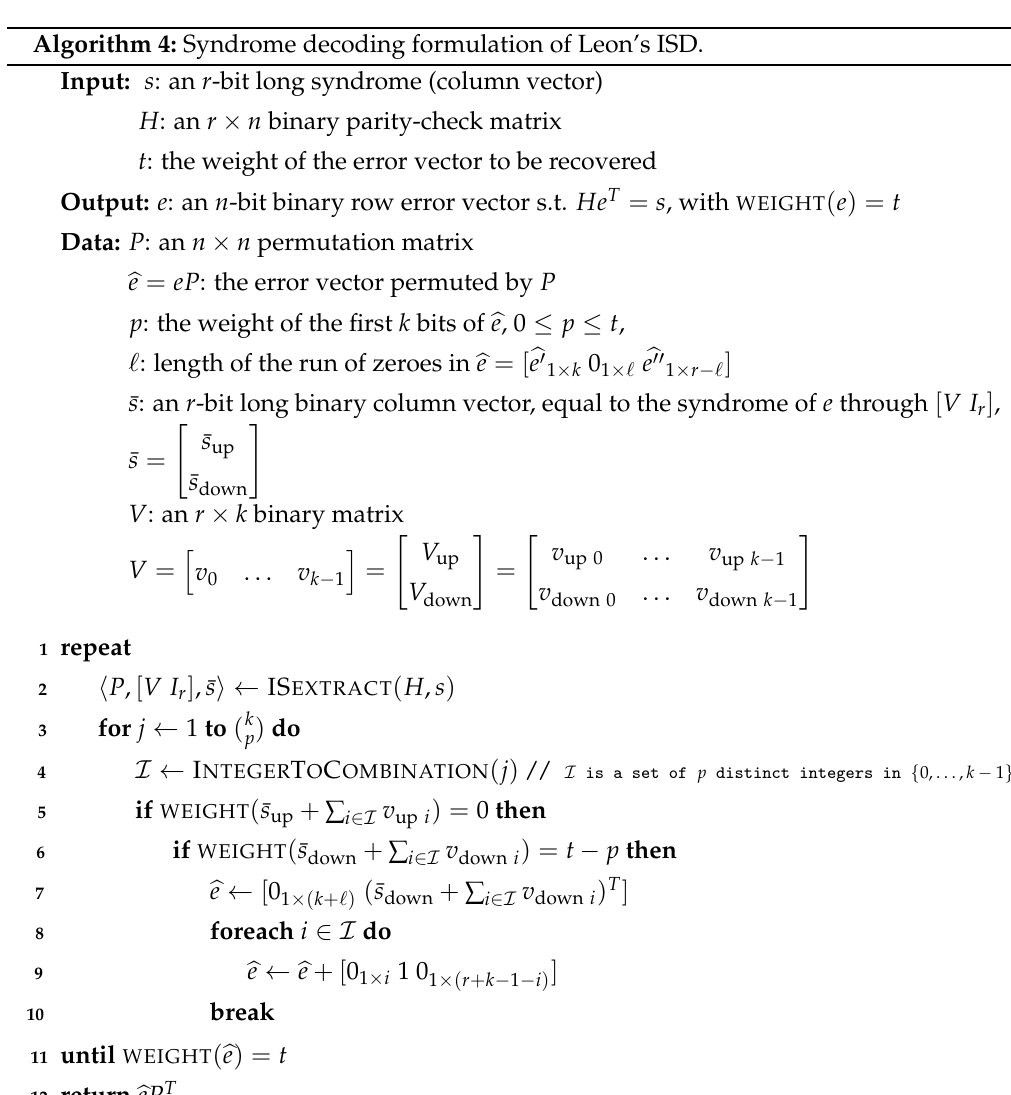
Algorithm 4: Syndrome decoding formulation of Leon’s